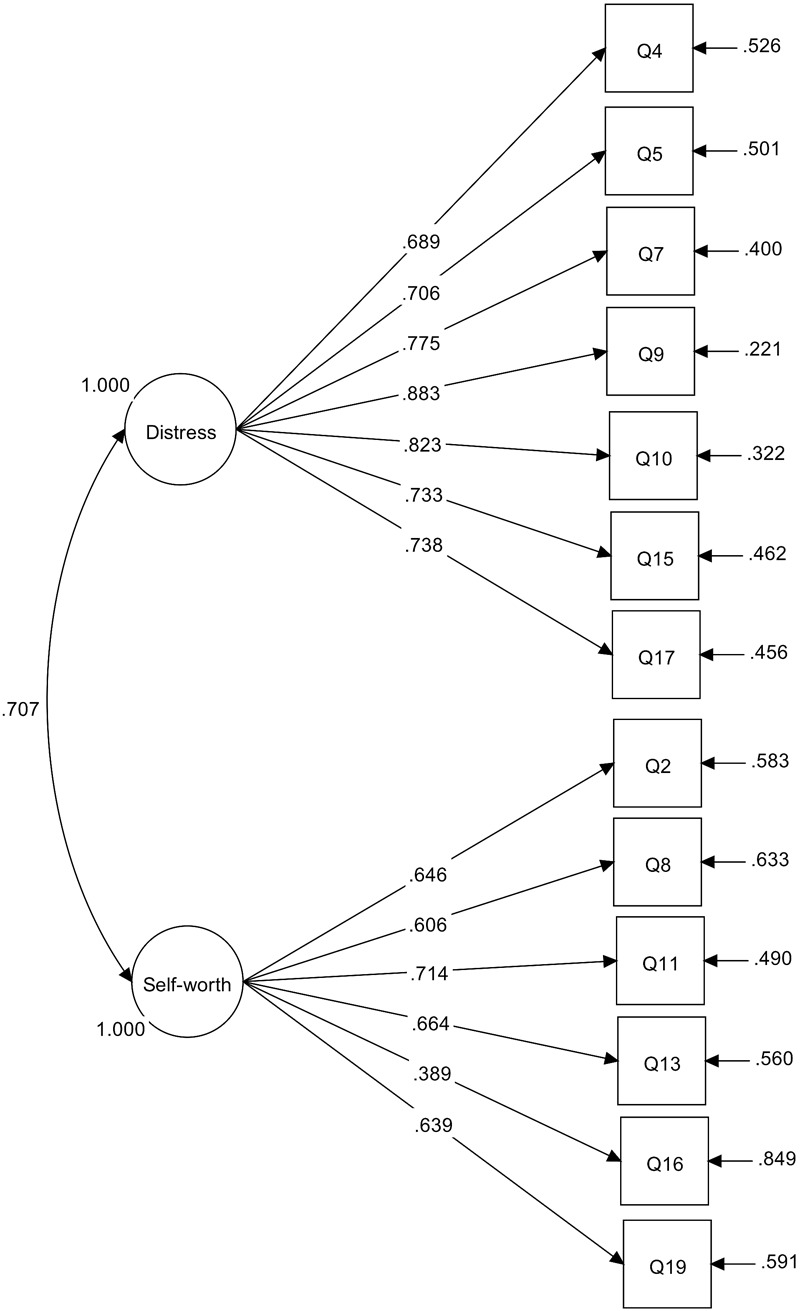
Measurement model for WBIS-2F subscales. Standardized parameter estimates are shown, all p < 0.000. Item numbers refer to numbering in original 19-item WBIS (Durso and Latner, 2008).